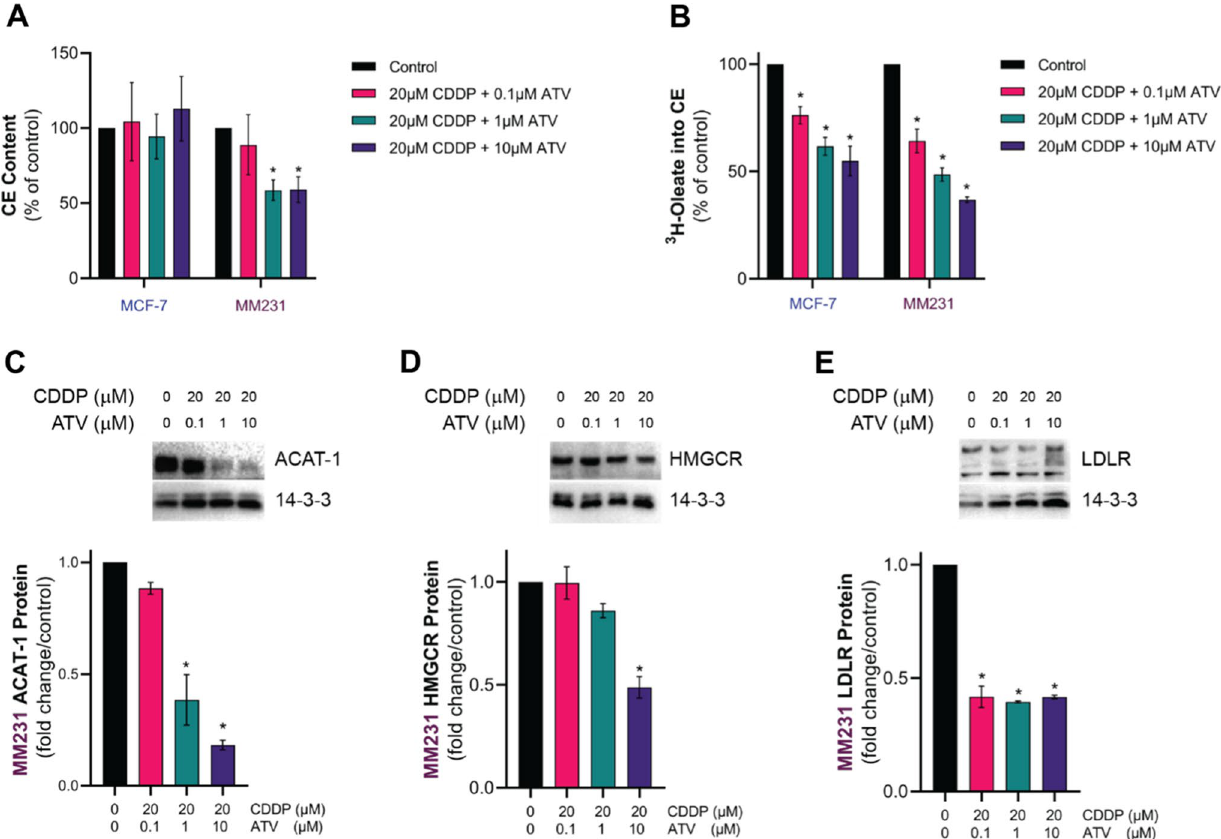
Fig. 6 BC cell CE metabolism after combined treatment with CDDP and ATV. MCF-7 and MDA-MB-231 (MM231) cell A CE content and B cho- lesterol esterification following culturing in growth media (Control) or media containing CDDP (20 µM) plus ATV for 48 h. Representative immunoblots and densitometric quantitation of C ACAT-1, D HMGCR and E LDLR protein levels in MDA-MB-231 cells treated with the sol- vent vehicle (Control) or CDDP plus ATV. Data are mean ± SEM of at least three independent experiments performed in triplicates. *p < 0.05 vs. Control (vehicle-treated cells) within each experiment by one-way ANOVA followed by Dunnett’s post hoc